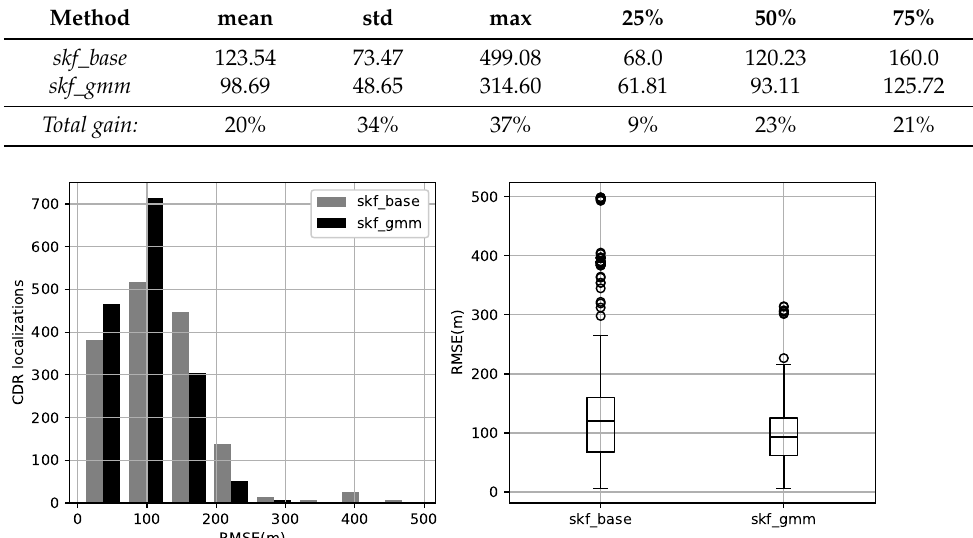
Figure 9. Evaluation of method’s localization accuracy using root means square error (RMSE) in meters between the ground-truth GPS location and method’s estimated location; baseline method skf_base using simple Gaussian to model the cell coverage vs. proposed method skf_gmm using Gaussian